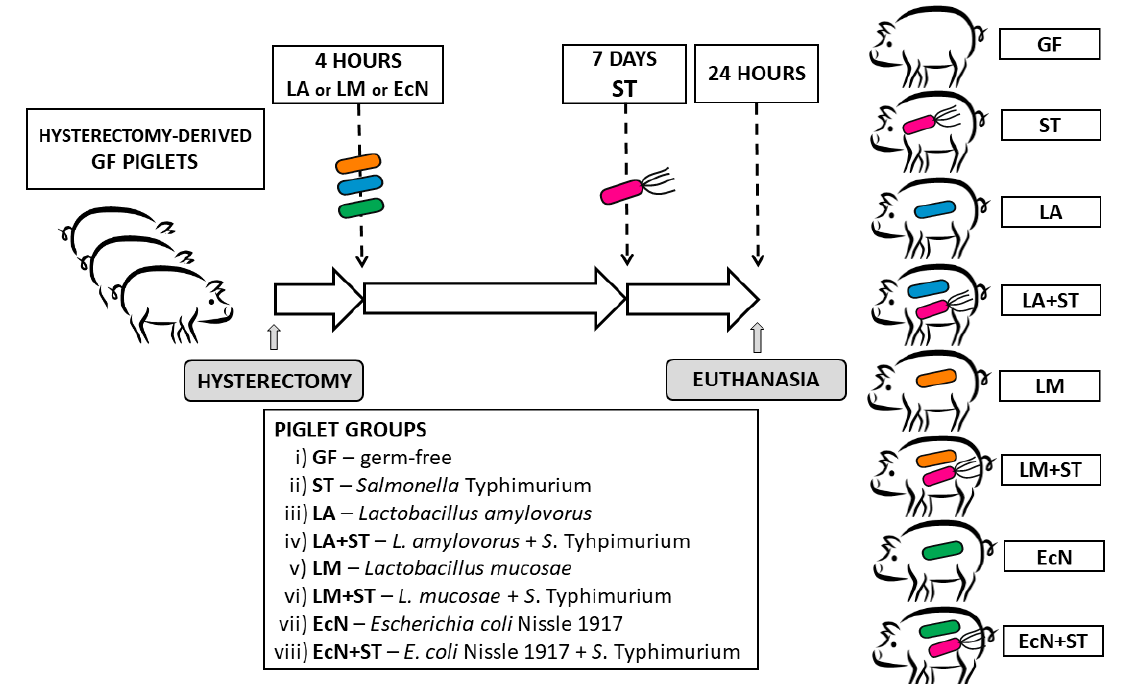
Figure 1. Schema of the experiment. The gnotobiotic piglets ( n = 55) were assigned into eight groups: (i) Germ-free (GF, n = 6); (ii) infected with S. Typhimurium for 24 h (ST, n = 7); (iii) colonized with L. amylovorus (LA, n = 7); (iv) LA-colonized and infected with S . Typhimurium for 24 h (LA + ST, n = 7); (v) colonized with L. mucosae (LM, n = 7); (vi) LM-colonized and infected with S . Typhimurium for 24 h (LM + ST, n = 7); (vii) colonized with E. coli Nissle 1917 (EcN, n = 7); and (viii) EcN-colonized and infected with S . Typhimurium for 24 h (EcN + ST, n = 7).